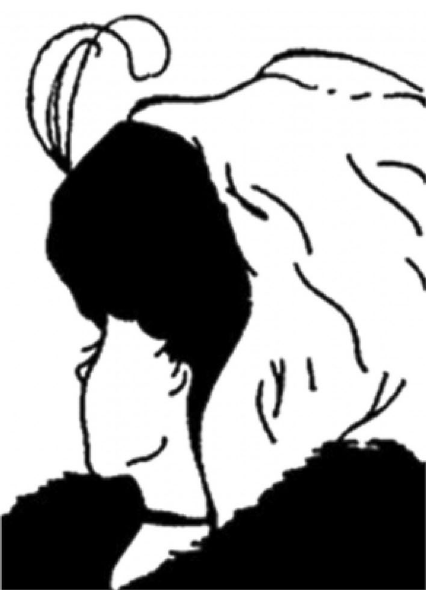
Figure 1. My Wife and My Mother-In-Law, by the cartoonist W. E. Hill, 1915. This media file is in the public domain in the United States. This applies to U.S. works where the copyright has expired, often because its first publication occurred prior to January 1,